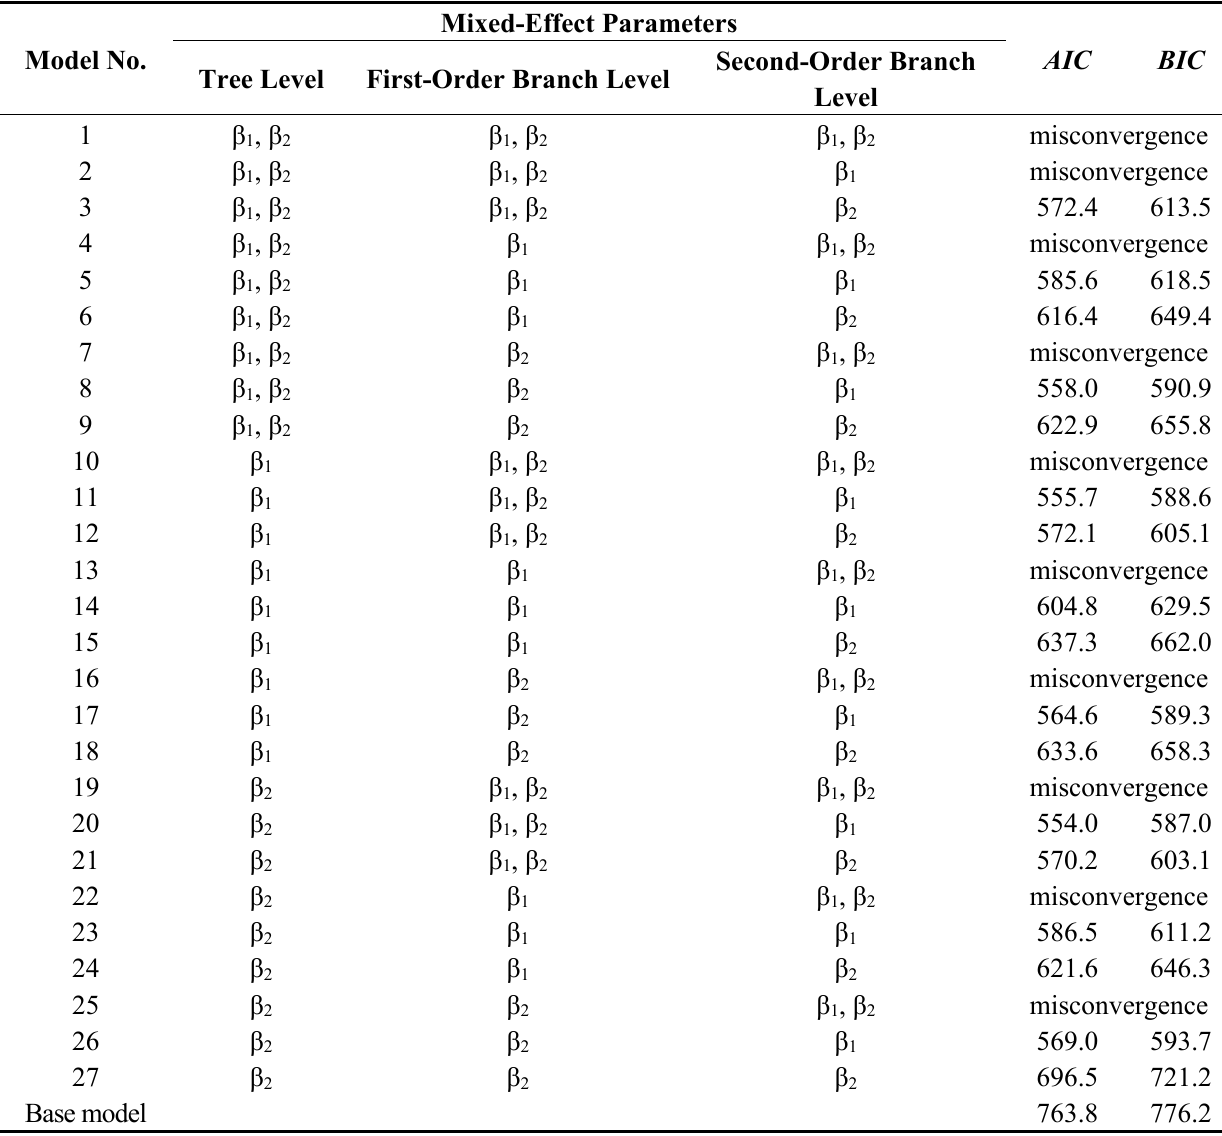
Table 5. Values of AIC and BIC of mixed-effect models and the base model for the third-order